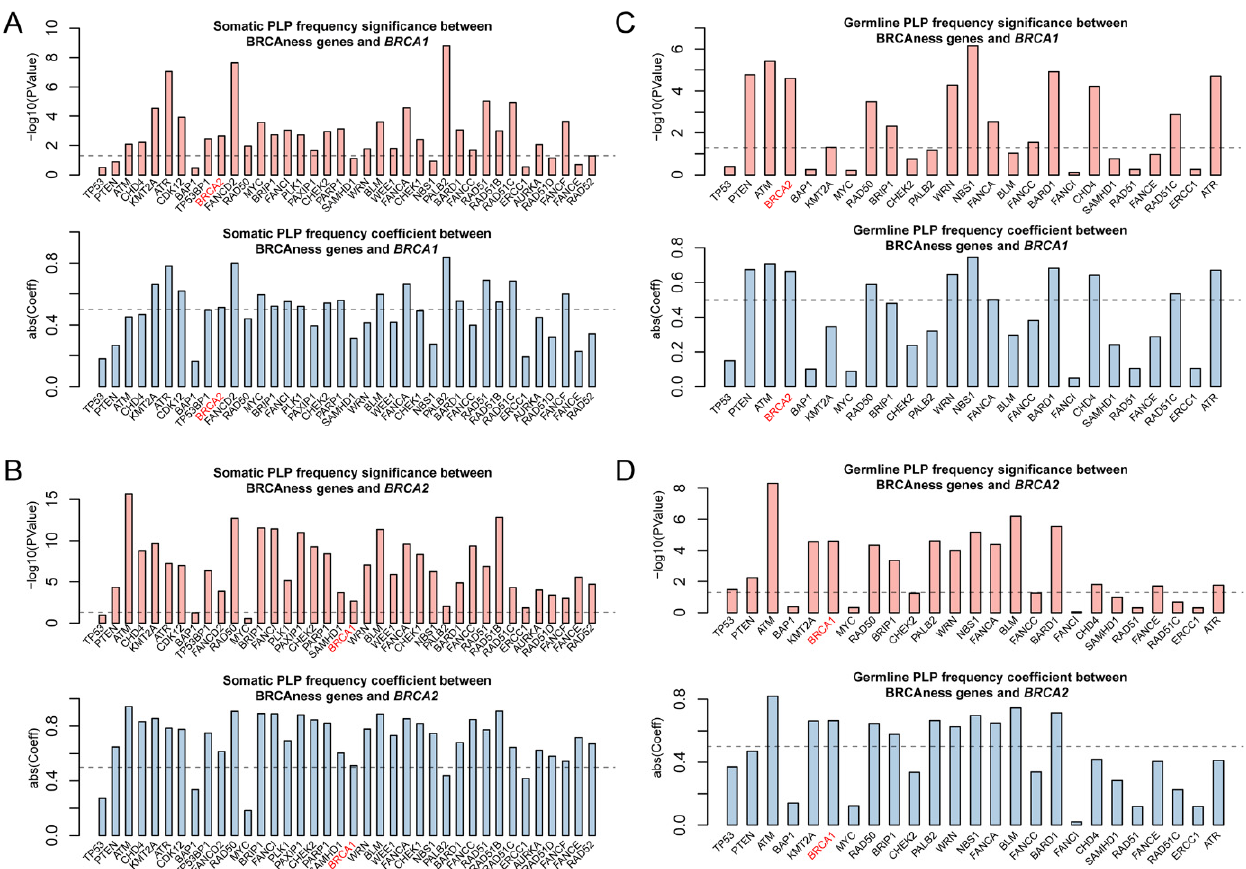
Figure 3. Correlation of pathogenic variation of BRCAness genes across 33 cancer types. ( A , B ) Significant correlation for the frequencies of somatic and germline pathogenic variants between individual BRCAness gene and BRCA1 . ( C , D ). Significant correlation for the frequencies of somatic and germline pathogenic variants between individual BRCAness gene and BRCA2 . The pairs with p - value < 0.05 were regarded as significant. The pairs with an absolute coefficient > 0.5 were regarded as significantly correlated.